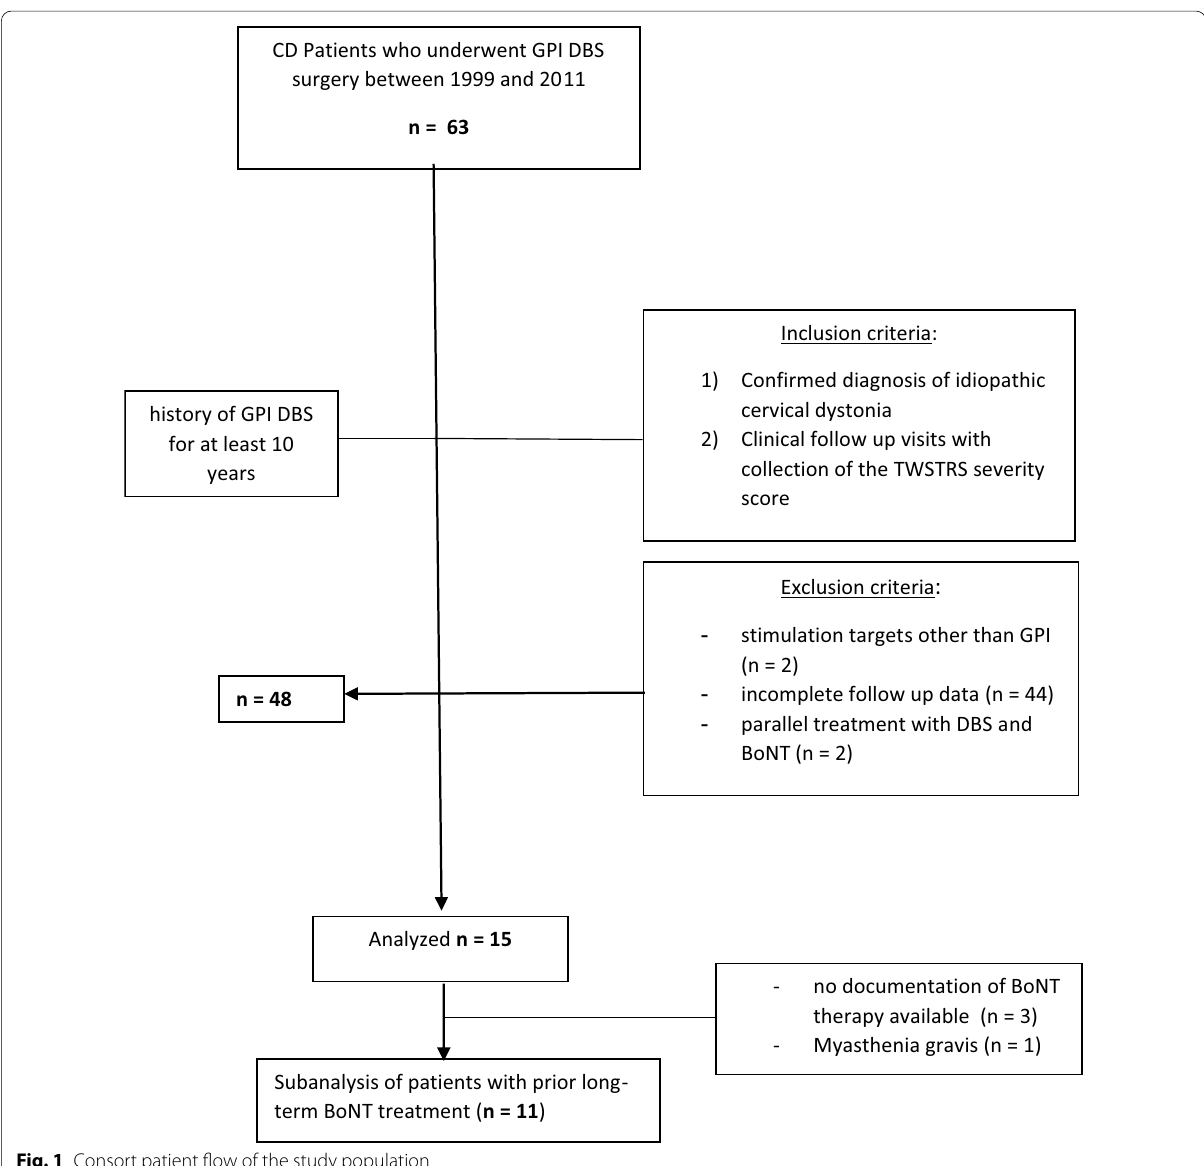
Fig. 1 Consort patient flow of the study